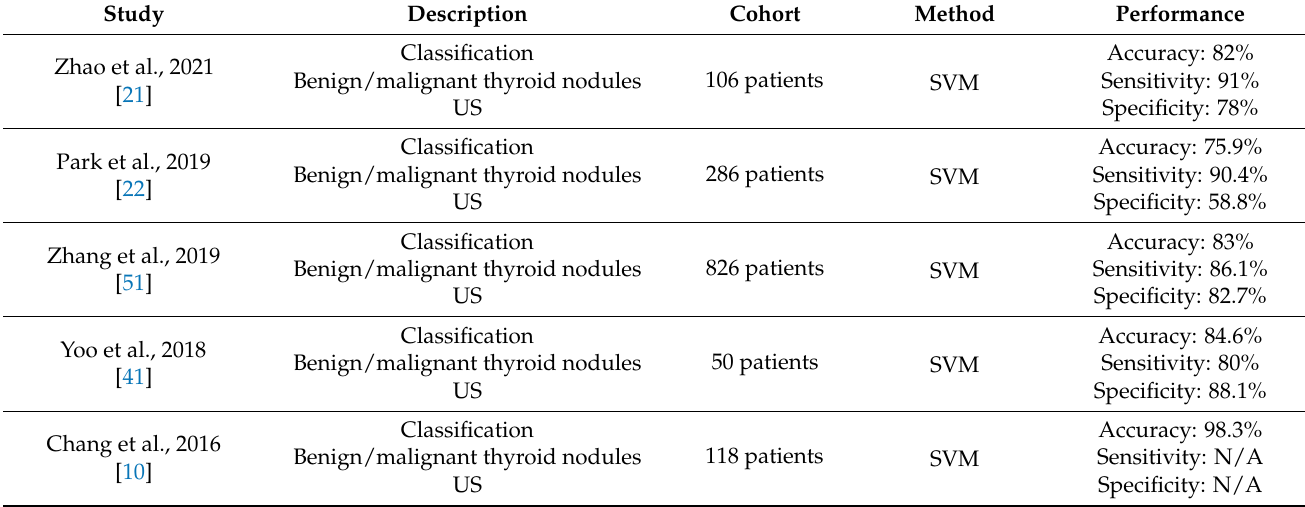
Table 1. Machine learning (ML)-based